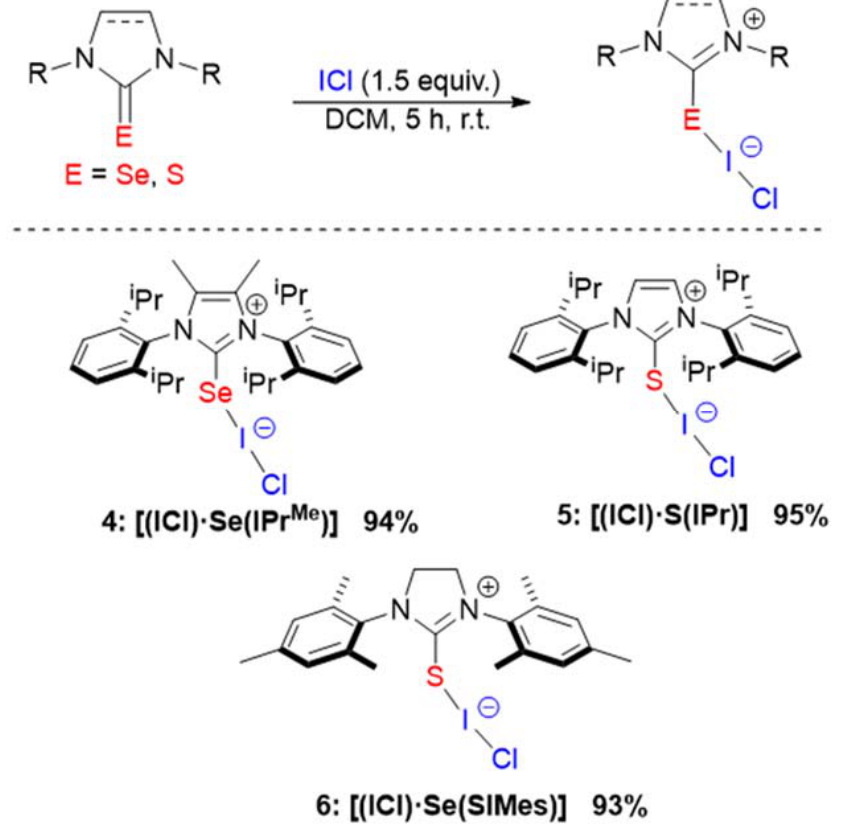
Figure 1. Chemical structures of seleno- and thiourea NHCs used in this work.